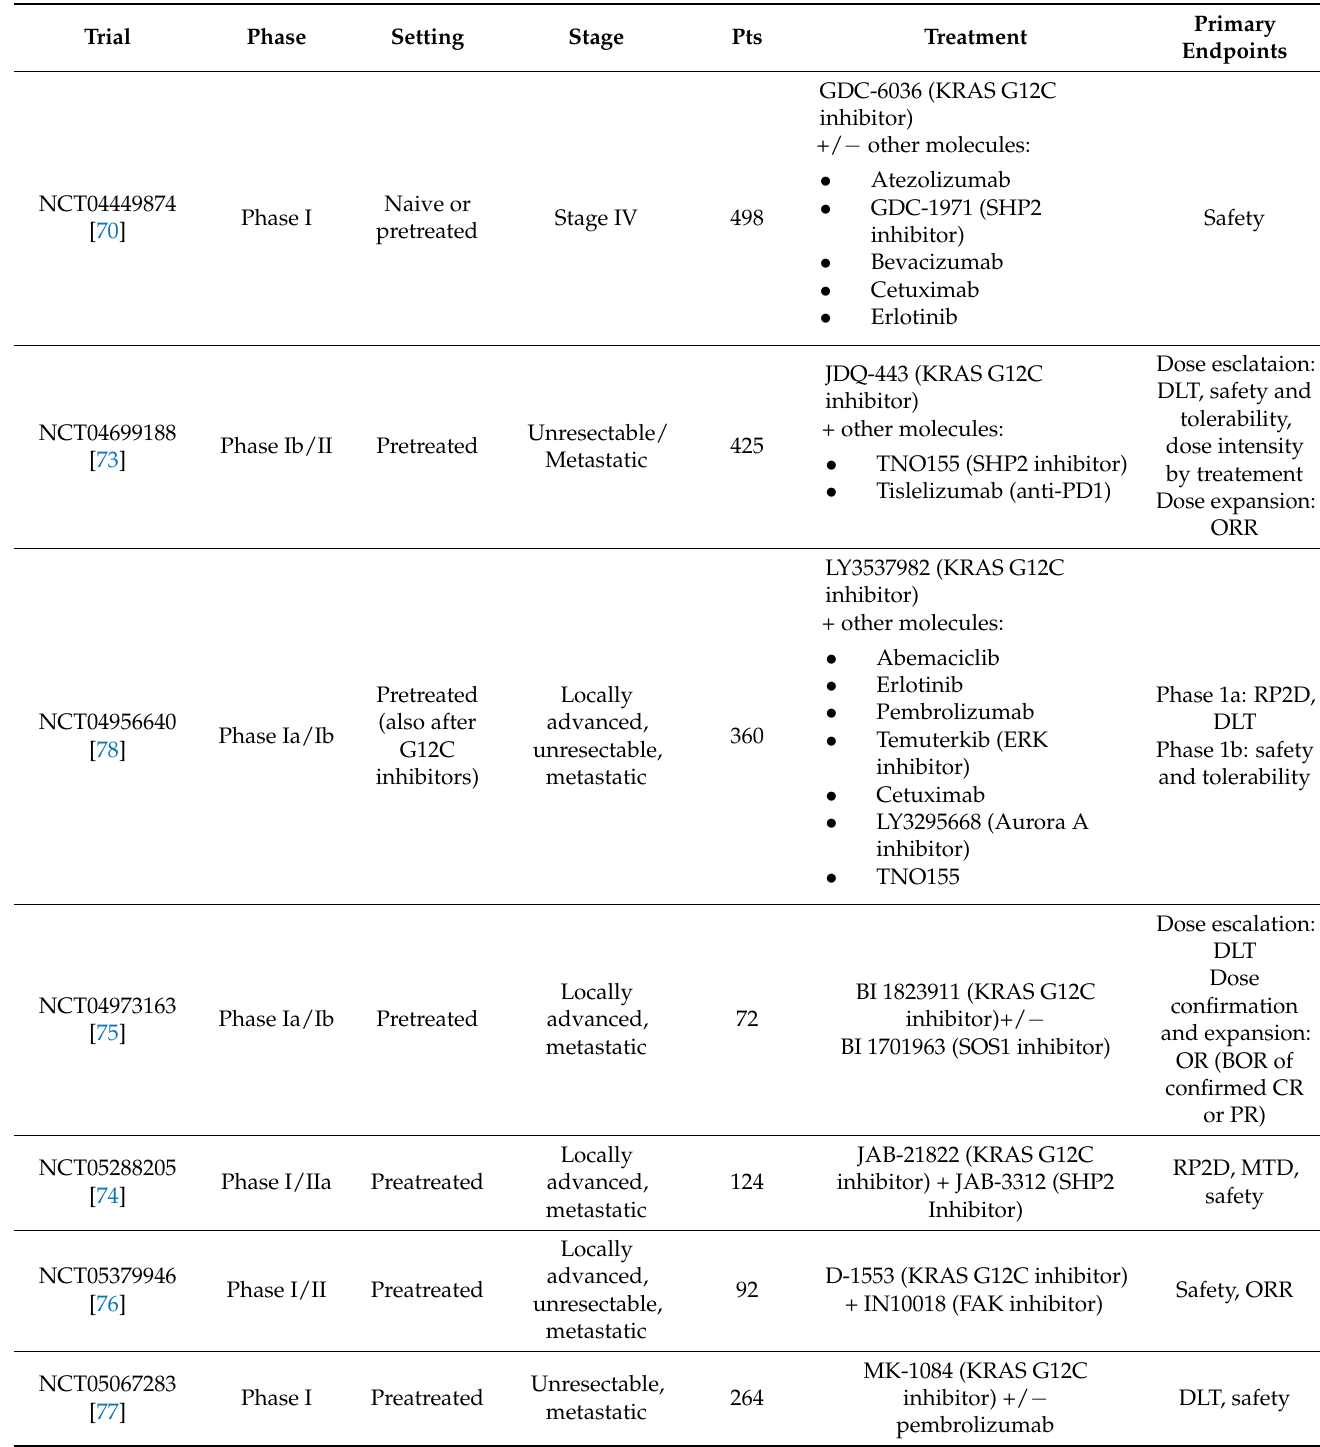
Table 2. Ongoing trials evaluating novel inhibitors for KRAS-G12 mutant advanced